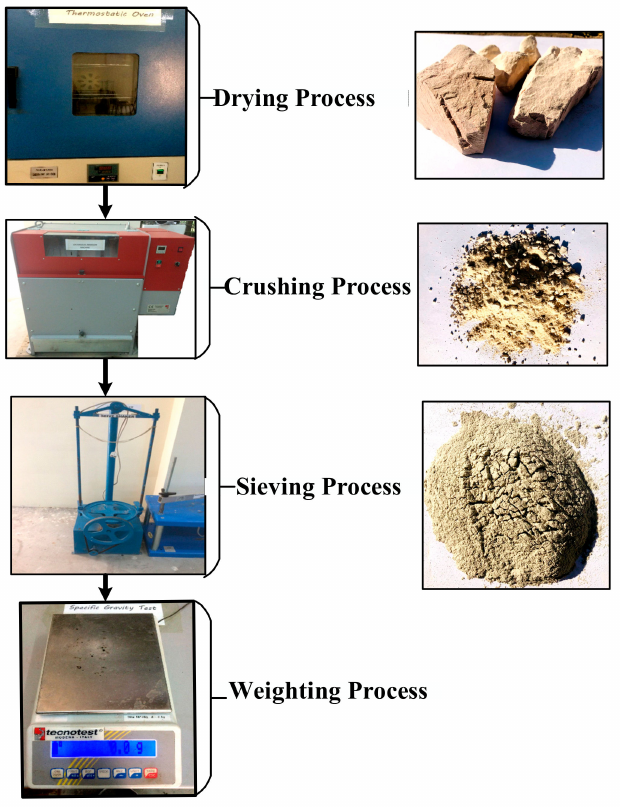
Figure 4. Sample preparation.